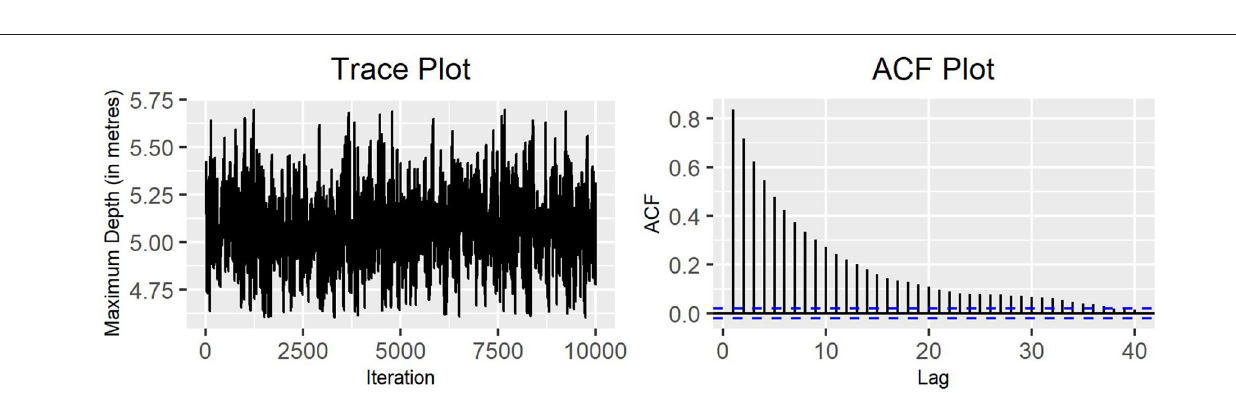
FIGURE 7 | Trace plot and ACF plot of the standard deviation of the variable maximum depth for production state 2, obtained running seven chains for parallel tempering on the MH algorithm (10,000